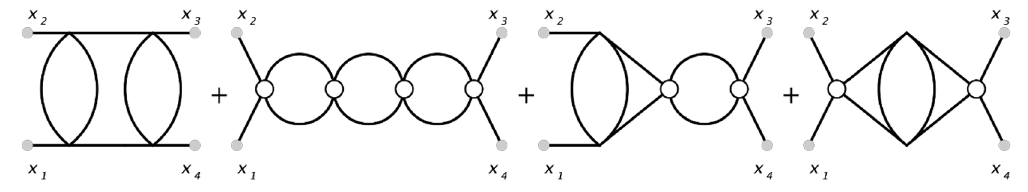
Figure 3 . Example of s-channel three loop diagrams in coordinate space which contribute to the double-trace correlation function h tr ( φ theory. White blobs correspond to the double-trace interactions. The full contribution is given by adding the same diagrams with x